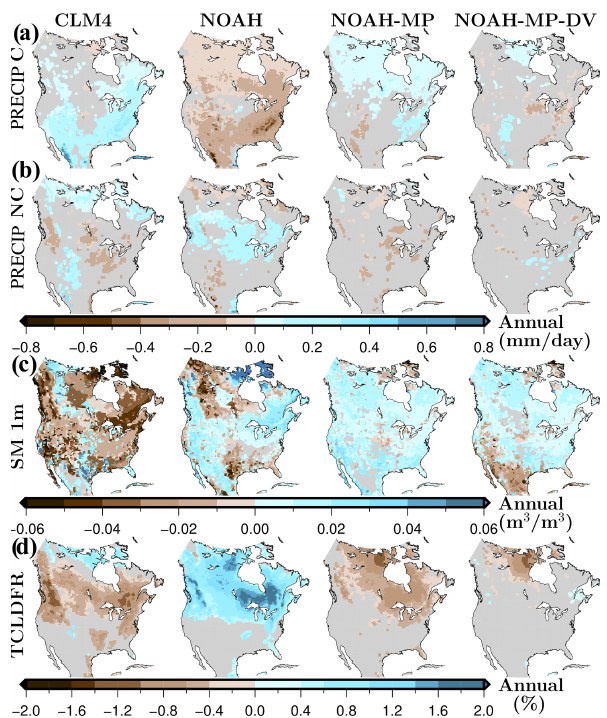
Figure 5. Anomalies of near-surface humid conditions: (a) accumu- lated convective and (b) non-convective precipitation at the surface (PRECIP C and PRECIP NC), (c) soil moisture contained in the first soil metre (SM 1m), and (d) total cloud fraction (TCLDFR) for each LSM simulation relative to the LSM ensemble mean. Mean values are estimated as the temporal average for the period 1980– 2013 using simulations performed with 50km resolution. Grid cells with a non-significant change at the 5% significance level are masked in